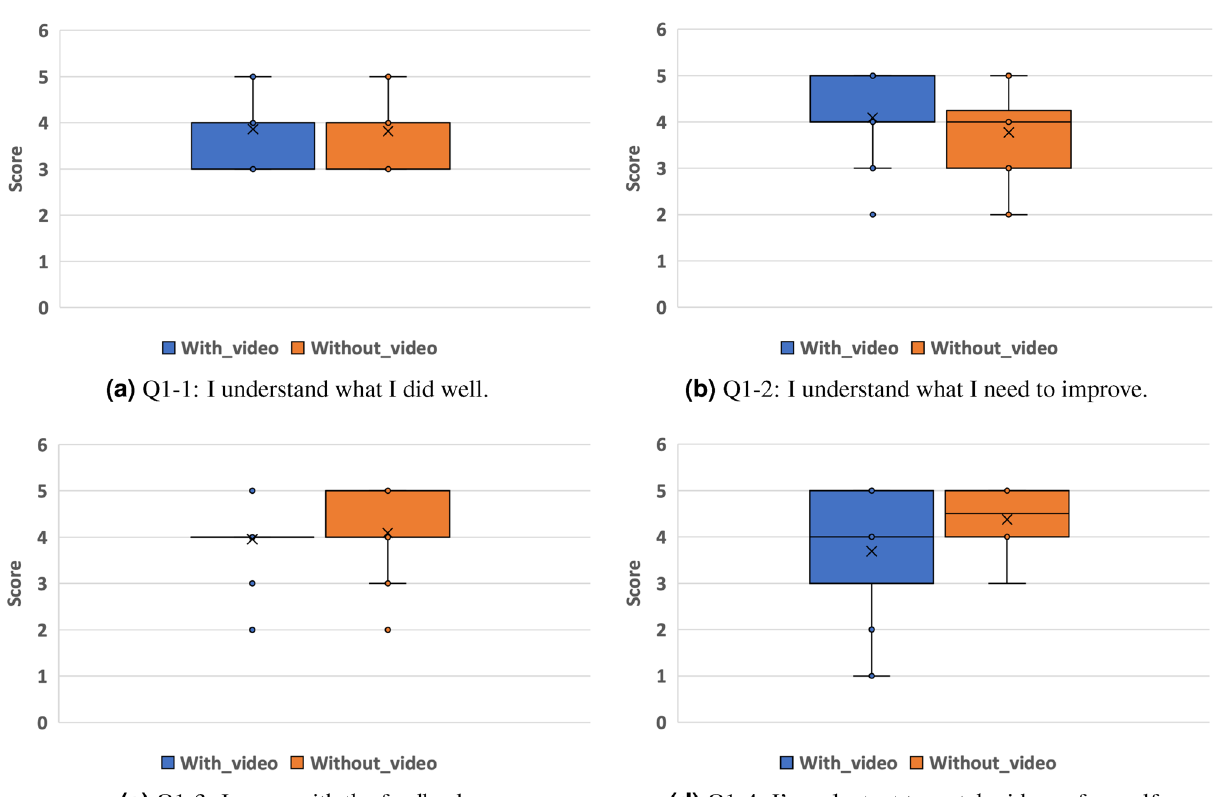
Figure 6. Questionnaire results concerning video